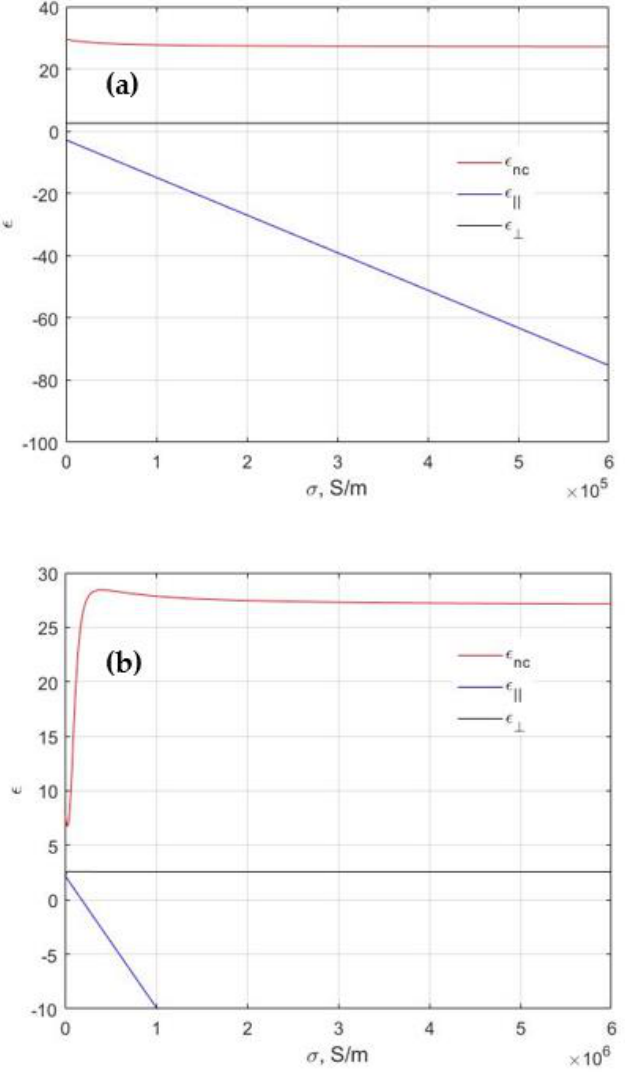
Figure 3. Relative permittivity components of the nanocomposite and hypercrystal versus conductivity. Herein, f = 0.3, ε n = 11.8, ε d = 2.25. Herein ITO inclusions are employed in nanocomposite and hypercrystal. ( a ) ω = 0.3 × 10 14 Hz; ( b ) ω = 3 × 10 14 Hz.